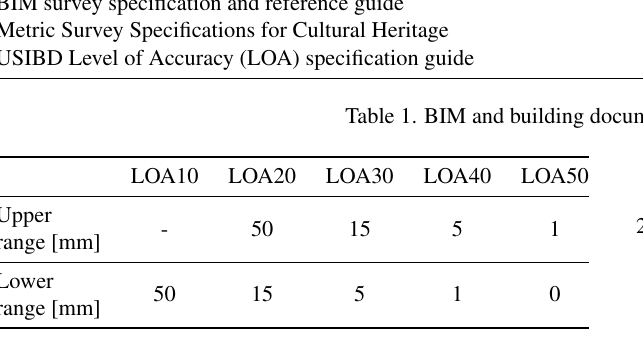
Table 2. Levels of